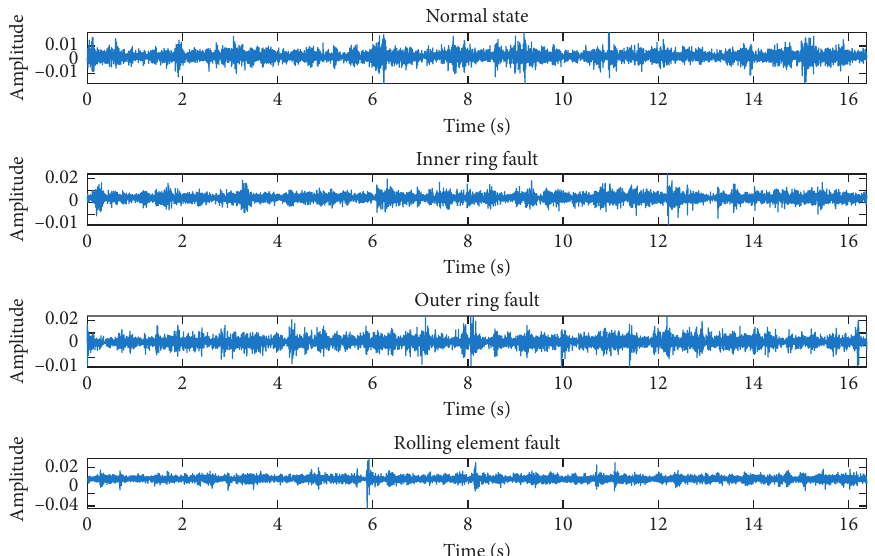
Figure 13: The time-domain diagram of four states of rolling bearing.